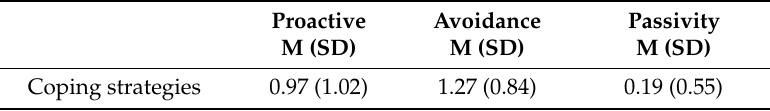
Table 2. Coping strategies used in the sample of victims ( n = 180).